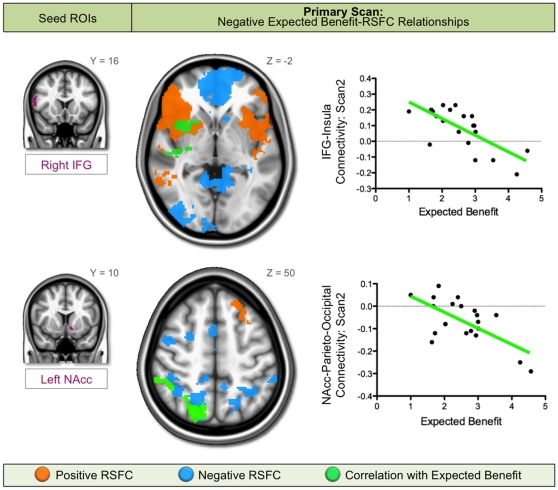
Negative relationships between expected benefit and RSFC from the Primary Scan analyses.A negative relationship with expected benefit was observed in the Primary Scan (Scan 2) for resting state functional connectivity (RSFC) between the right inferior frontal gyrus (IFG) pars opercularis seed and right insula (top row), and the left nucleus accumbens (NAcc) seed and right parieto-occipital cortex (bottom row). These negative relationships were observed as either decreasing positive connectivity (green overlaid on red-orange) or increasing negative connectivity (green overlaid on light blue) in the voxel-wise correlation maps (middle column). These relationships are also illustrated in the scatter plots comparing RSFC values and expected benefit scores (right column).